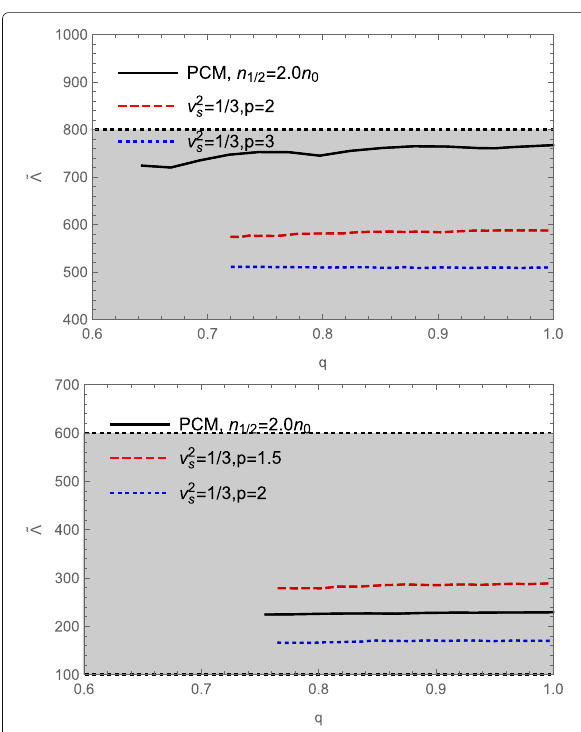
Fig. 9 The dimensionless tidal deformability ˜ (cid:20) as a function of the mass ratio q for GW170817 with chirp mass 1.188 M (cid:3) (upper panel) and GW190425 with chirp mass 1.44 M (cid:3) (lower panel). The the PCM prediction with n 1 / 2 = 2.0 n 0 is plotted in solid line and those by [77] are in dashed and dot-dashed lines (see Ref. [77] for notation). The grey band in the upper panel is the constraint from the low spin ˜ (cid:20) = 300 + 500 − 190 obtained from GW170817 [5] and that in the lower panel is ˜ (cid:20) ≤ 600 from GW190425